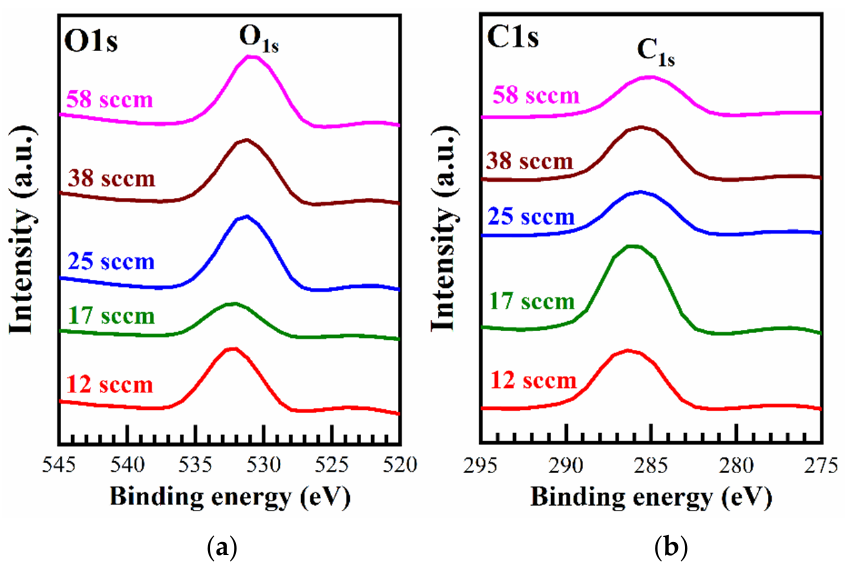
Figure 5. XPS core levels spectra of ( a ) O 1s, and ( b ) C 1s for the TaN films at different N 2 flows (12–58 sccm, 10 min deposition).